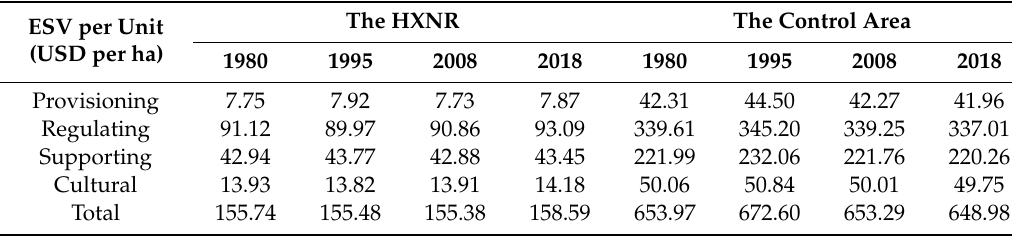
Table 6. The average ESV per unit in the study area during 1980–2018.